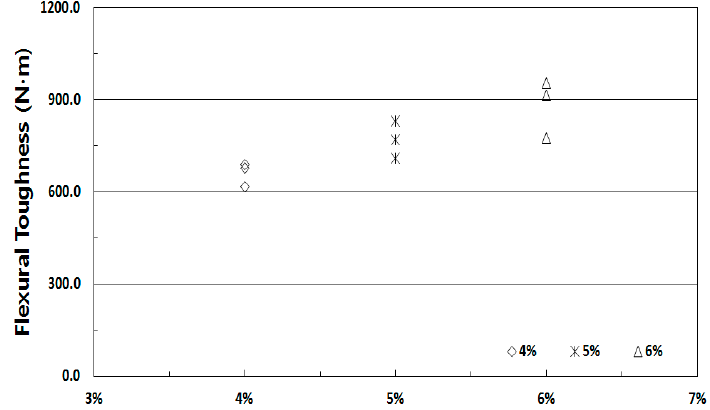
Figure 7. Test results of flexural toughness with respect to fiber volume fraction.